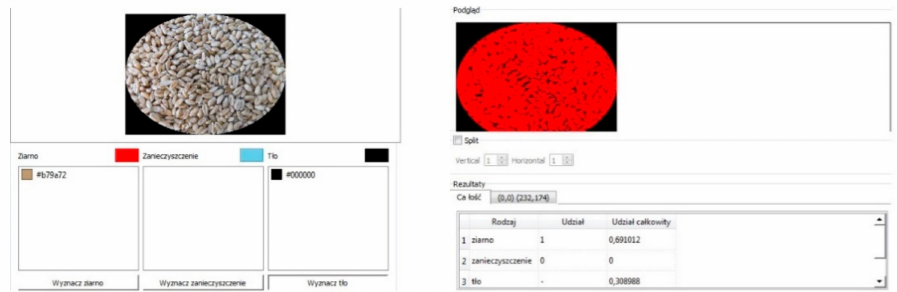
Figure 5. The analysis of digital image of wheat grain contamination for a randomly selected sample [own source].